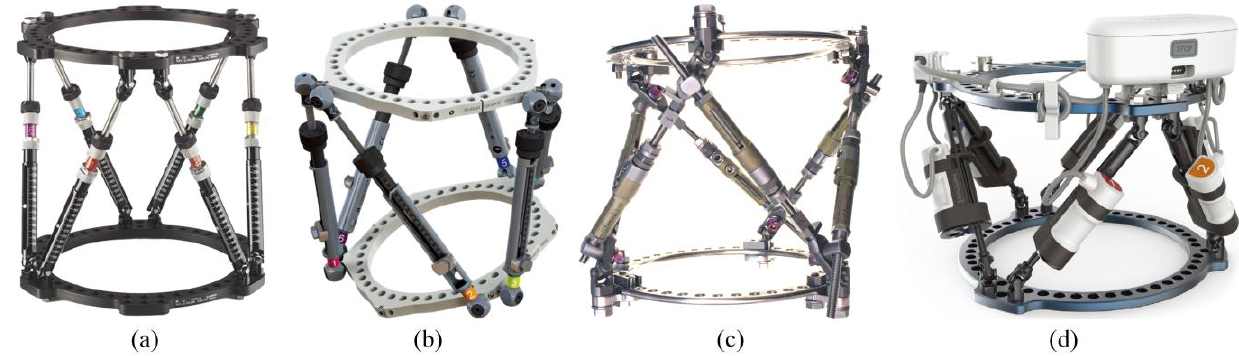
Figure 1. Commercial external fixation devices including ( a ) Taylor Spatial Frame, ( b ) TL-HEX, ( c ) Ortho-SUV, and ( d ) Auto Strut.